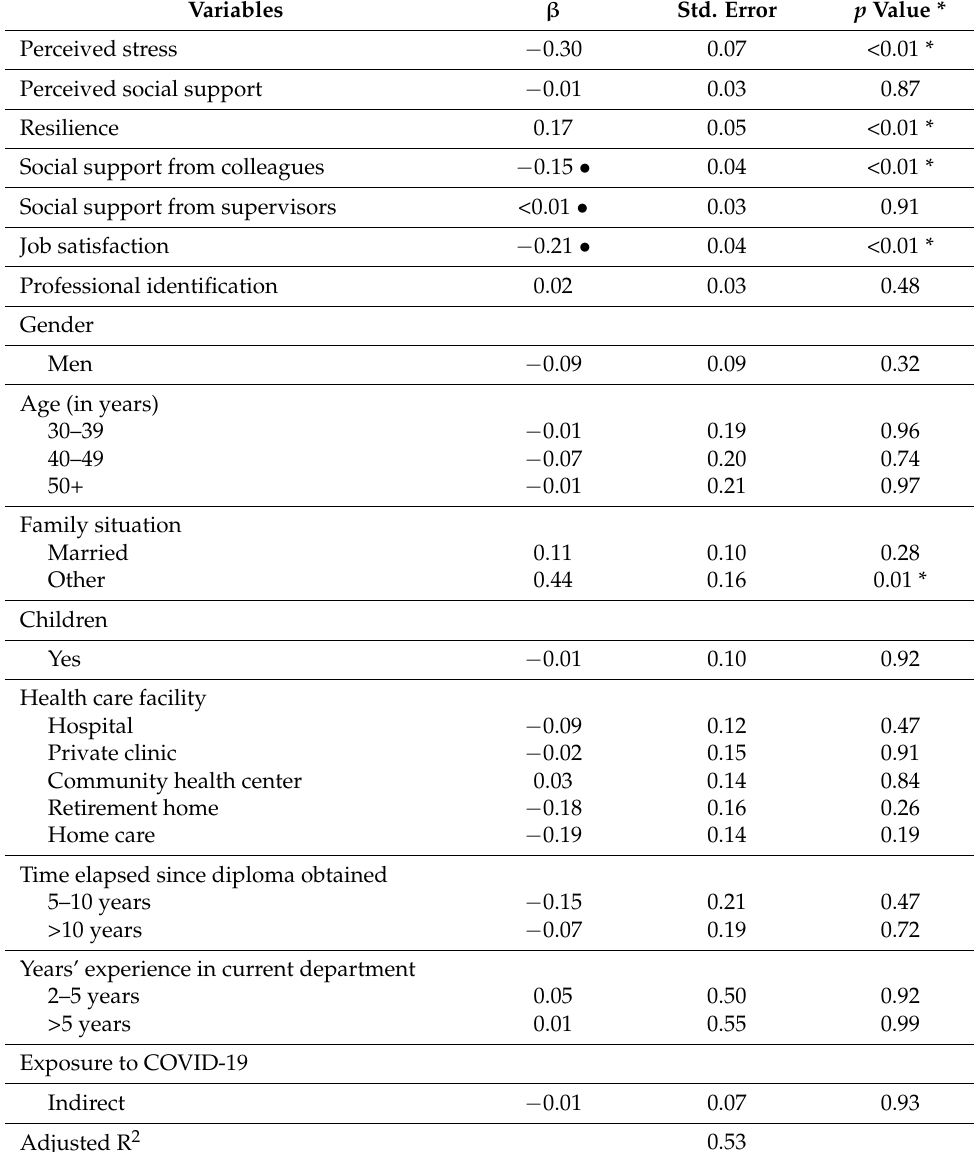
Table 4. Association between stressors/protective factors and workplace wellbeing. Variables β Std. Error p Value * Perceived stress −